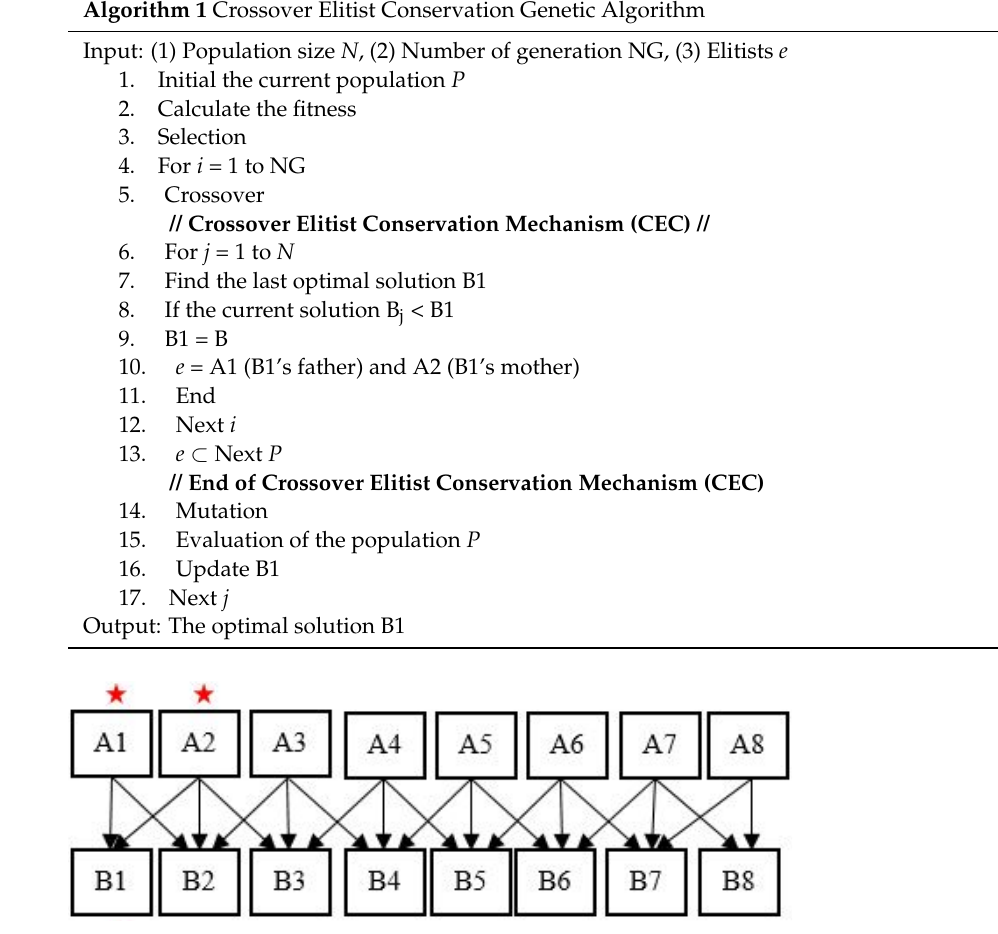
Algorithm 1 Crossover Elitist Conservation Genetic Algorithm